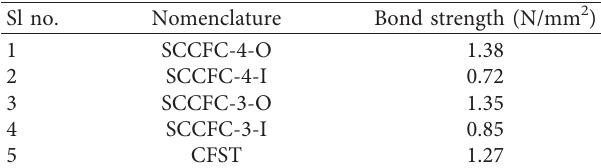
Table 3: Bond strength of the specimens tested. Sl